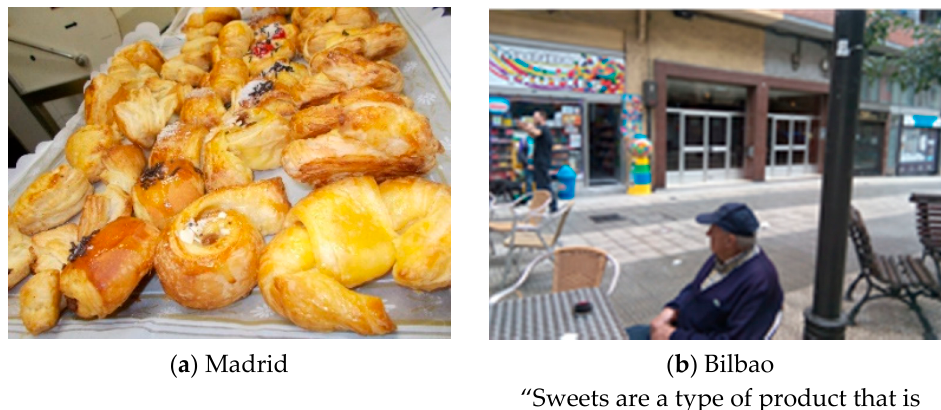
Figure 1. ( a ) Photograph made in Madrid: “At the bakery”. Category: Non processed pastries. Theme: Eating in moderation; ( b ) Photograph made: “Sweet world”. Category: Leisure. Theme: unhealthy eating.